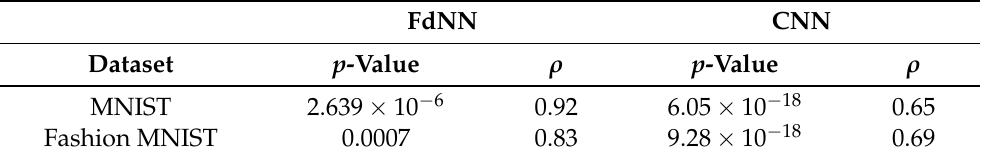
Table 8. Mean values for Spearman’s correlation test between the NN number of synapses and the categorical accuracy for each simulation experiment regardless of the quantization level.